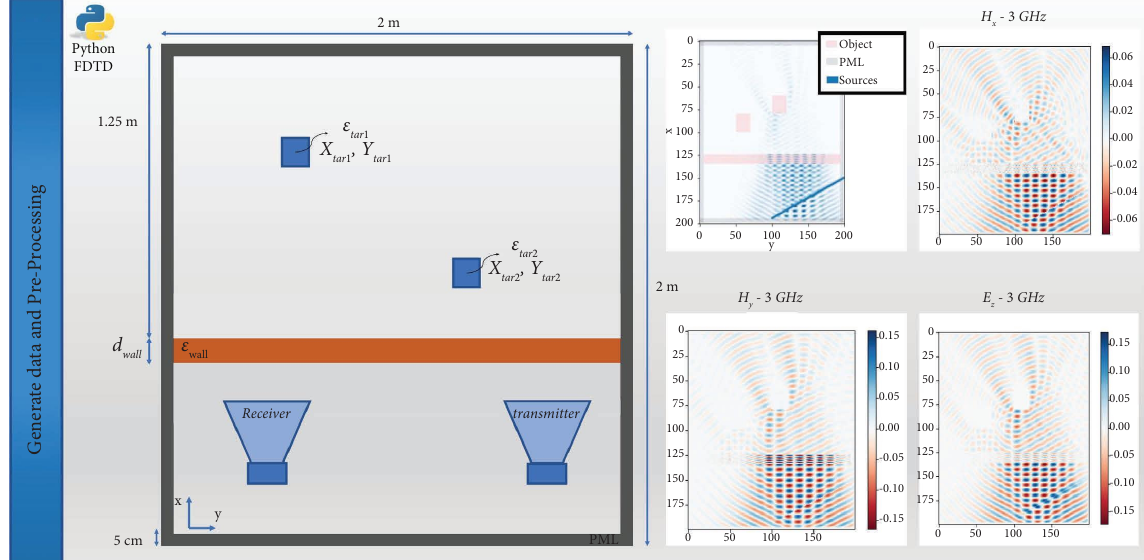
Figure 2: Environment and parameters required for generating the dataset. Simulations performed for the felds E available in the